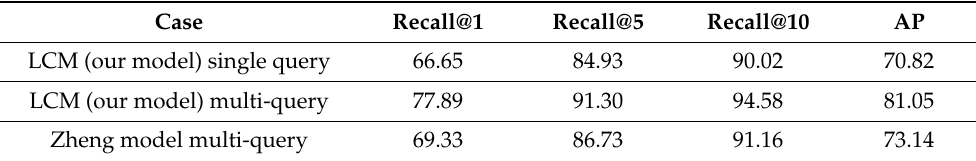
Table 5. The matching accuracy (%) of multiple queries based on the